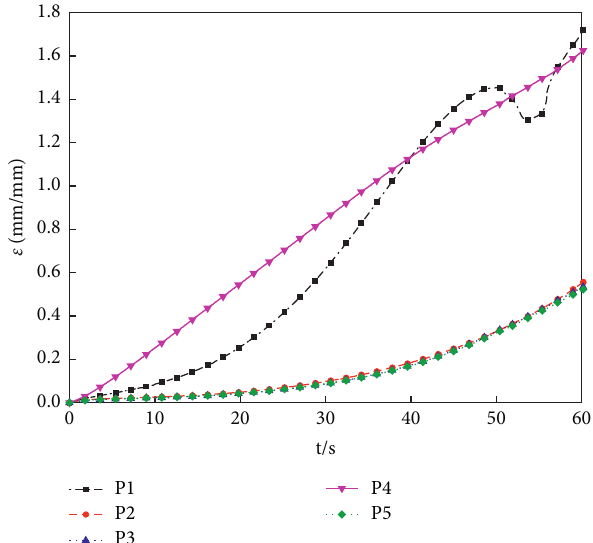
Figure 5: Curve of strain vs. deformation time of spots derived from Figure 4 (P1 ∼ P5).